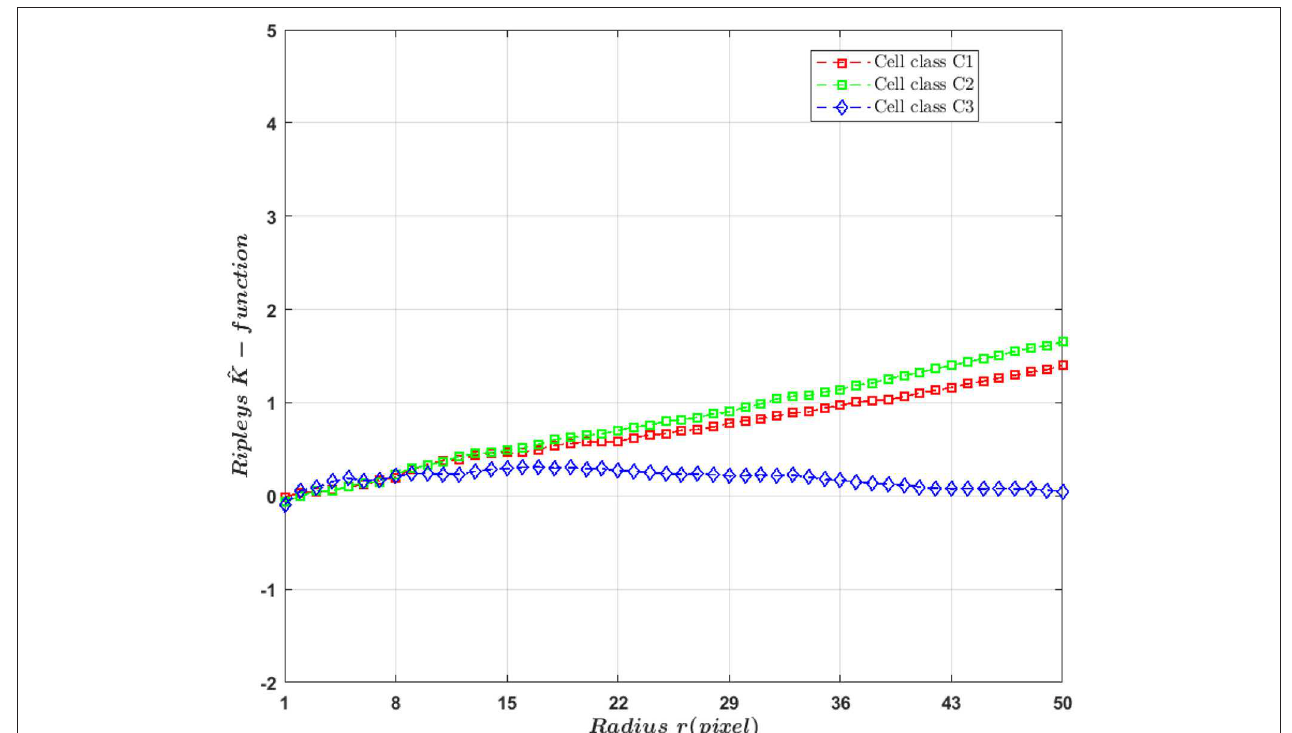
FIGURE 6 | ˆ K ( r , n ) curve for raw markers (i.e., non-convolved with a PSF) distribution according to radius r .